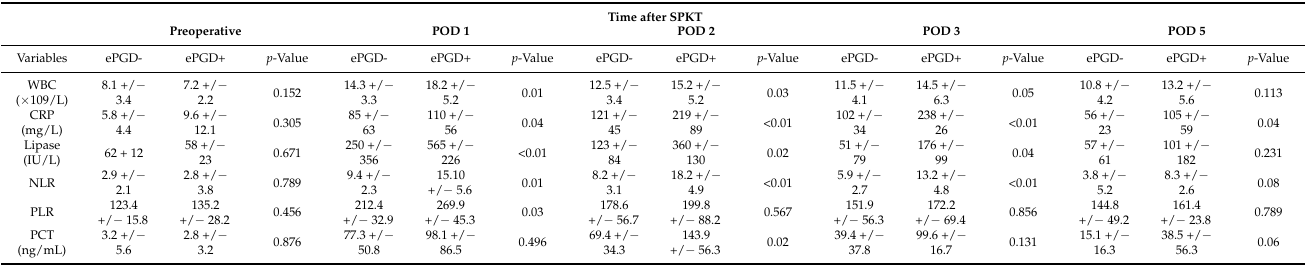
Table 3. Pre-and postoperative WBC, CRP, lipase, NLR and PCT levels stratified by early pancreatic graft dysfunction